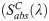
Parameters necessary for calculation of ratio factor A for Cerulean and Venus fluorescent proteins.(A) Spectra of the optical components in the excitation path of the imaging system. Ssrc(λ), Sex(λ), Sdichr(λ), Sobj(λ) are spectra for the light source (Polychrome V monochromator, TILL Photonics, yellow), excitation filter (Chroma 69008x, blue), dichroic mirror (Chroma 69008bs, green) and objective (Olympus UAPO 40XOI3/340, black), respectively, mounted on Olympus IX71 microscope. Point-by-point multiplication of spectra for each optical element yields an optical function of microscope excitation light path shown by a violet trace. This excitation optical function of the particular imaging system can be used for calculation of a ratio factor A for a wide range of different fluorescent labels. (B) Further point-by-point multiplication of the optical function (violet), normalized Cerulean absorption spectrum (SabsC(λ) (blue), and a spectrum of monochromator slit chosen for a given experiment (orange) gives a function of excitation path for Cerulean (black). Integration of this function and multiplication by the extinction coefficient for Cerulean absorbance results in EexC, necessary for estimation of the ratio factor A (see Eq 1). (C) Spectra of the optical components in the emission path of the imaging system. Sobj(λ),Sdichr(λ),Sem(λ),Sdet(λ) are objective (Olympus UAPO 40XOI3/340, black), dichroic mirror (Chroma 69008bs, green), and emission filter (Chroma 69008m, dotted red) transmittance and detector (QImaging ExiBlue, brown) sensitivity, respectively. Point-by-point multiplication of spectra for each optical element gives an optical function of microscope emission path shown by a red bold trace. This emission optical function of the particular imaging system can be used for calculation of a ratio factor A for a wide range of different fluorescent labels. (D) Further point-by-point multiplication of the optical function (red dashed trace; left Y axes) and Cerulean emission spectrum, integral of which is normalized to 1, (SemC(λ)) (blue dashed trace; right Y axes) gives the function of emission path for Cerulean (black trace, right Y axes). Integration of this function and multiplication by Cerulean quantum yield results in EemC.